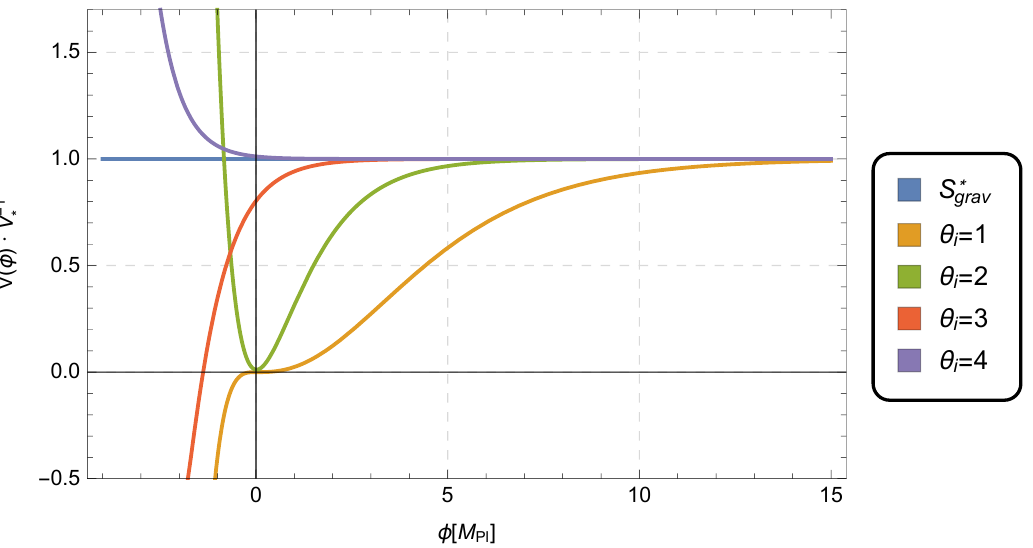
Figure 1. Inflationary potential V ( φ ) generated by the conformal transformation of the fixed-point action S ∗ grav , Equation (10), and of the effective action Equation (9) for various values of the critical exponents θ i in the range θ i ∈ ( 0,4 ] . The fixed-point action S ∗ grav gives rise to a flat potential V ∗ = 8 π g ∗ λ ∗ M 4 fixed-point epoch, and corresponds to a perfectly scale-invariant regime. Moving away from the NGFP, the renormalization group flow generates additional operators which destabilize the fixed-point potential V ∗ . The form of the modified potential V ( φ ) = V ∗ + δ V ( φ ) depends on the deviation δ L = f RG ( R ) from the fixed-point regime realized in the Jordan frame. Modeling this variation by means of the RG-improved model (4), the analytical form of the inflationary potential V ( φ ) is determined by the critical exponents θ i . Interestingly, the case θ 1 = θ 2 = 2 reproduces the well-known Starobinsky model. The departure from the fixed-point regime modifies the inflationary potential such that V (cid:48) ( φ ) (cid:54) = 0 at φ ∼ M Pl , and thereby induces a nonzero kinetic energy, ˙ φ i ∼− V (cid:48) ( φ i ) /3 H ( t i ) , for the inflaton field. This quantity provides an initial boost for the subsequent evolution of the scale factor a ( t ) , i.e., for t > t i , according to Equation